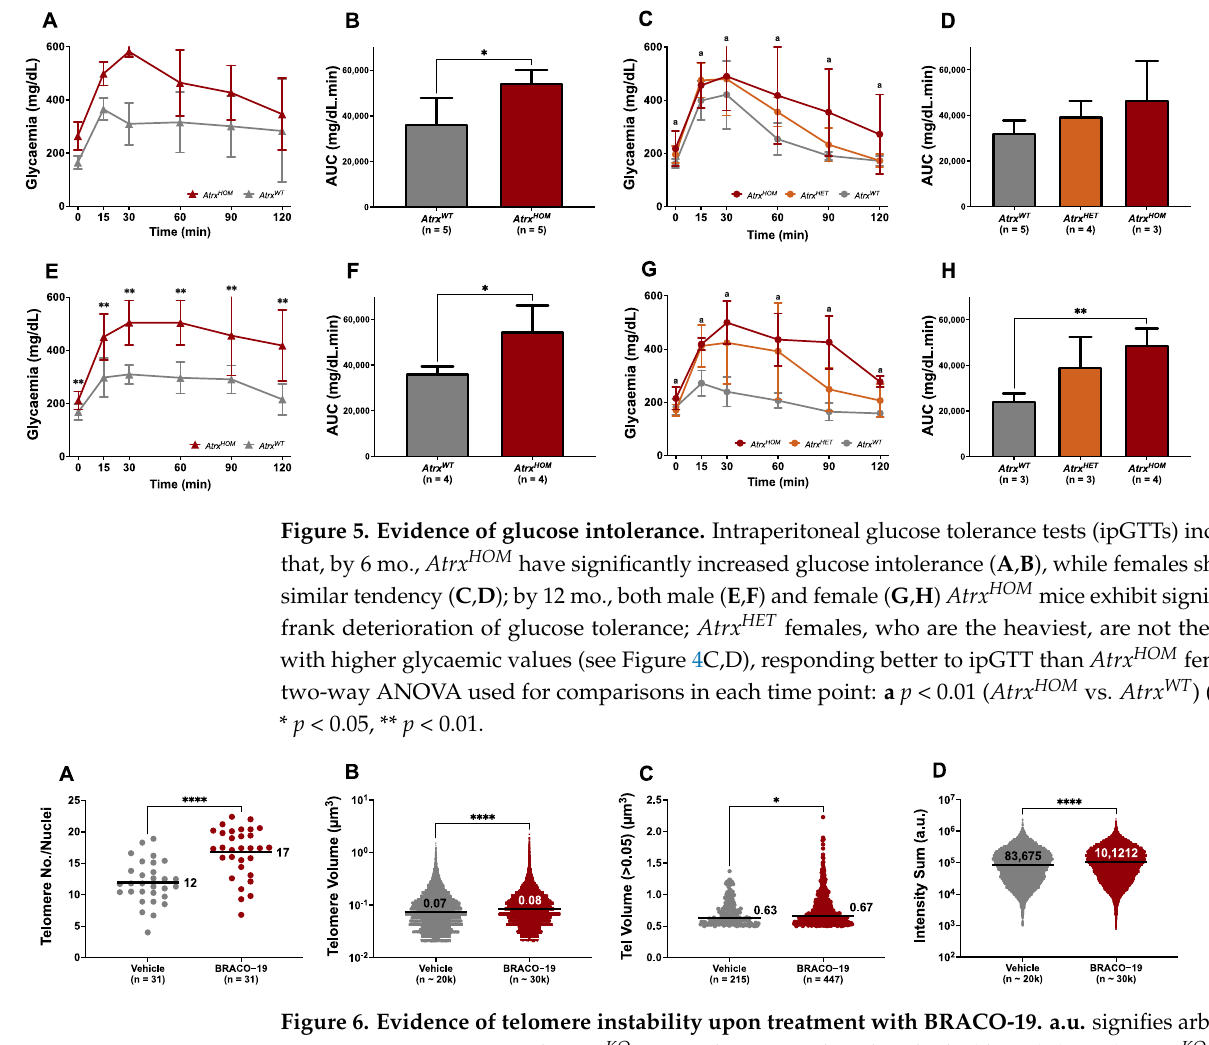
Figure 6. Evidence of telomere instability upon treatment with BRACO-19. a.u. signifies arbitrary units. In comparison with Atrx KO mice administered with vehicle (dH 2 O) ( n = 4), Atrx KO mice administered with BRACO-19 ( n = 4) for 40 days exhibit significantly higher number of telomeres per pancreatic islet cell nuclei ( A ), significantly increased telomere volume ( B,C ), and significantly increased intensity sum of FITC-stained telomeres ( D ). Data of graph A passed the normality tests, an unpaired t-test was then performed, and the mean values are presented. Data of graphs B–D did not pass the normality tests, so Mann–Whitney tests were then performed, and the median values are presented. A Log 10 scale and an Antilog tick format were used for the representation of the intensity sum ( D ). * p < 0.05, **** p < 0.0001.